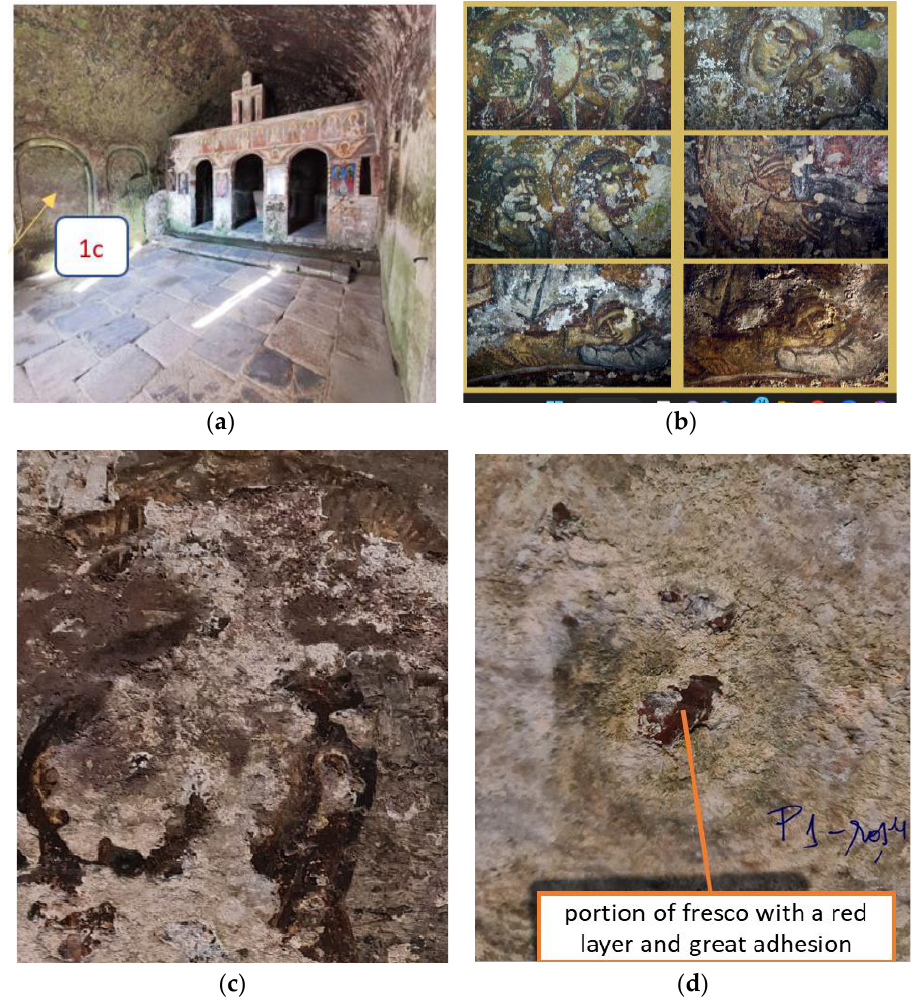
Figure 1. Corbii de Piatra Church: ( a ) an overview of 2022; ( b ) the layout of the mural paintings in 2011 [2]; ( c ) the state of the painting in 2022; and ( d ) the place where the fragment of the fresco with the red paint layer was taken.